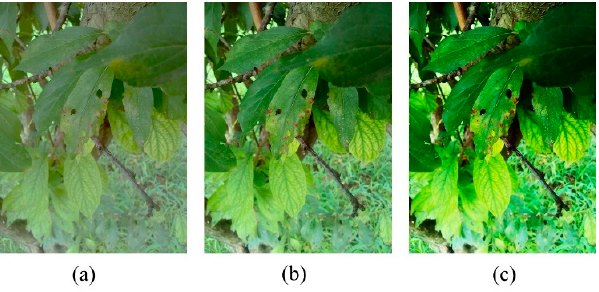
Figure 2. ( a ) Low-contrast, ( b ) medium-contrast, and ( c ) high-contrast images.